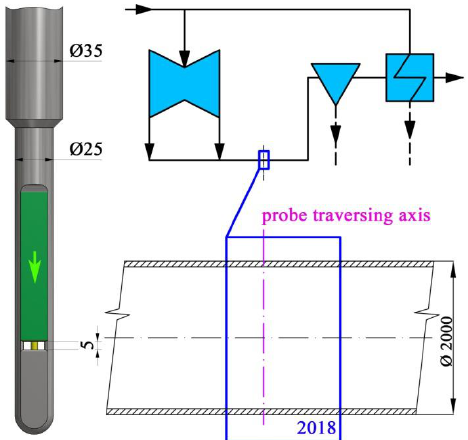
Fig. 12. Expected placement of the HP ext. probe in the piping During the design of the HP instrumentation, all the knowledge gained at CTU regarding the interaction between the probe and the flow field has been taken into account. The shape of the boundary surfaces of the measuring space has therefore been adjusted to minimize the influence of the flow. In view of the uncertainty in determining the spectrum of the droplet diameters by means of numerical simulations and in order to use the probe in other operating conditions, other particle sizes and, alternatively, for other pressures, a probe head with a variable geometry of the measuring space has been designed. By moving the part of the head (shown